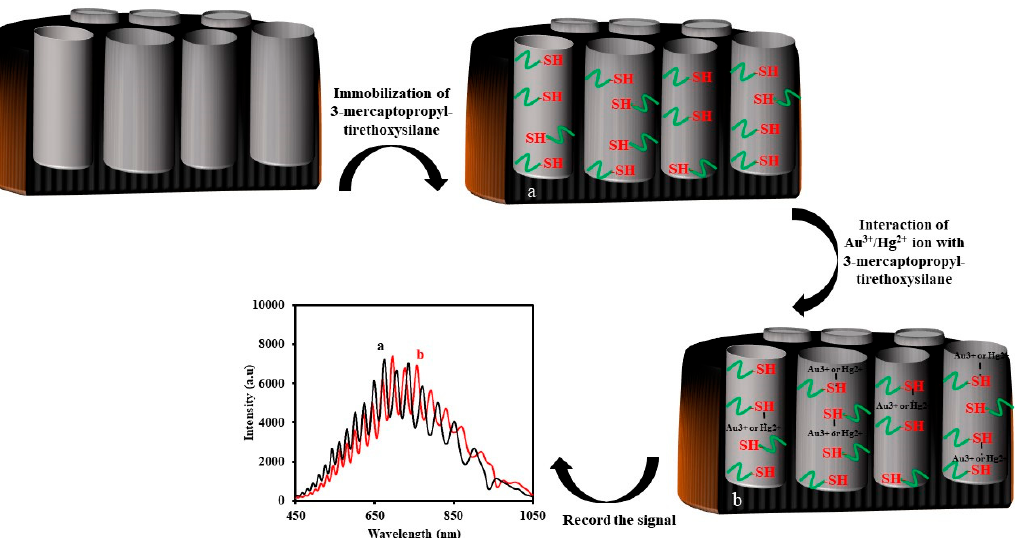
Figure 16. Schematic representation for the fabrication of the interferometric reflectance spectroscopy IRS based sensor for mercury (II) Hg 2 + or gold ion (III) Au 3 + ion sensing.